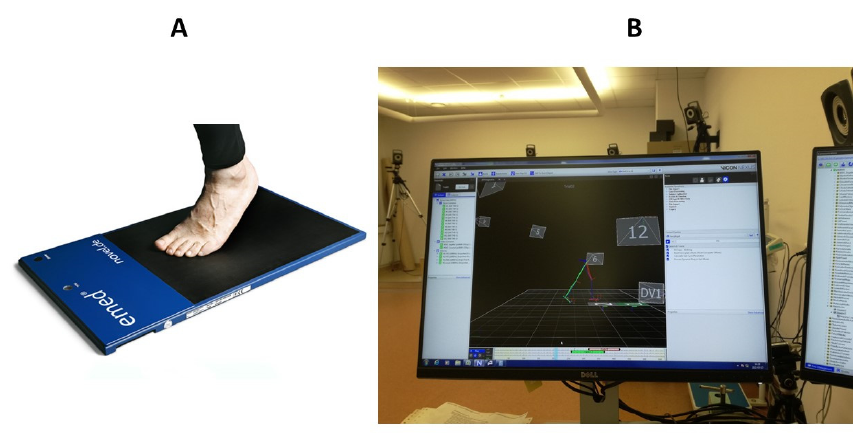
accessed on 28 November 2021). ( B ) Instrumented gait Figure 2. ( A ) Gait trial during pedobarography (photo from Novel’s web page www.novel.de, ac- cess date 15 December 2021). ( B ) Instrumented gait analysis.